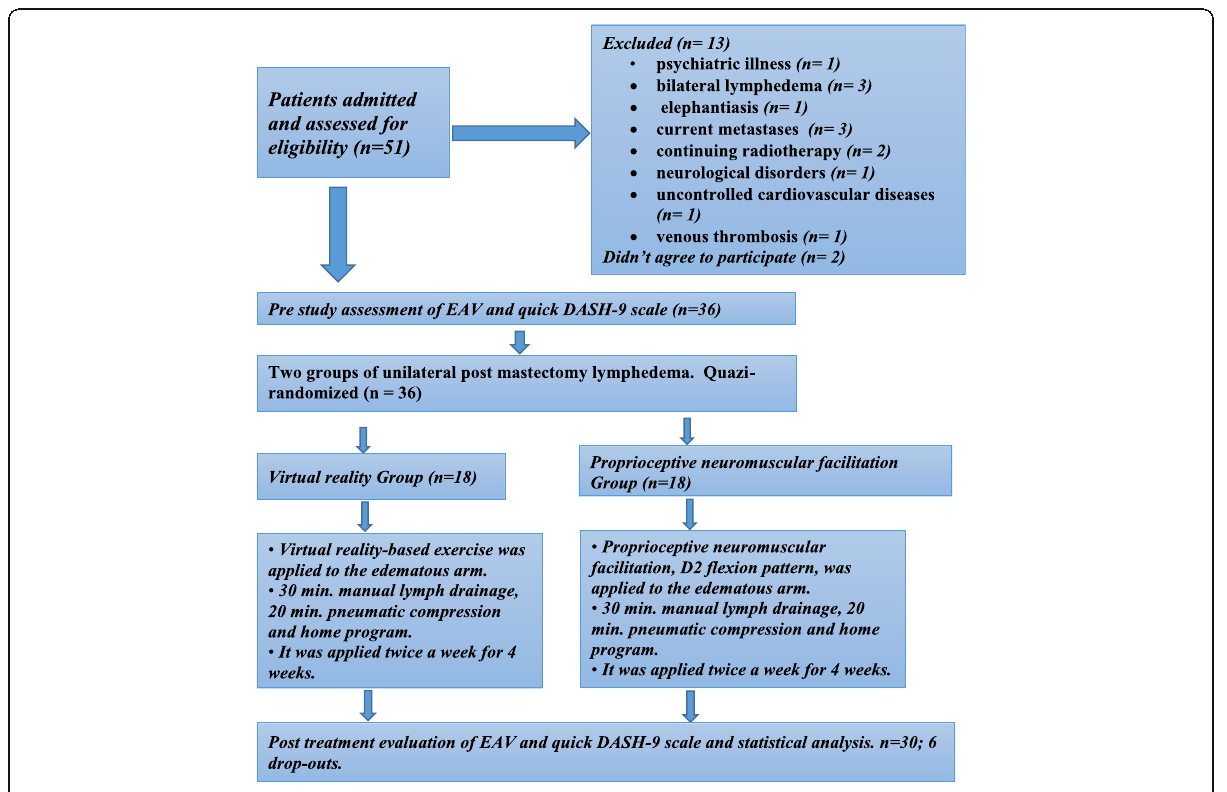
Fig. 1 Participants ’ inclusion process flowchart showing those with unilateral postmastectomy lymphedema who underwent the QuickDASH-9 assessment, excess arm volume (EAV) measurement, virtual reality-based exercise, and proprioceptive neuromuscular